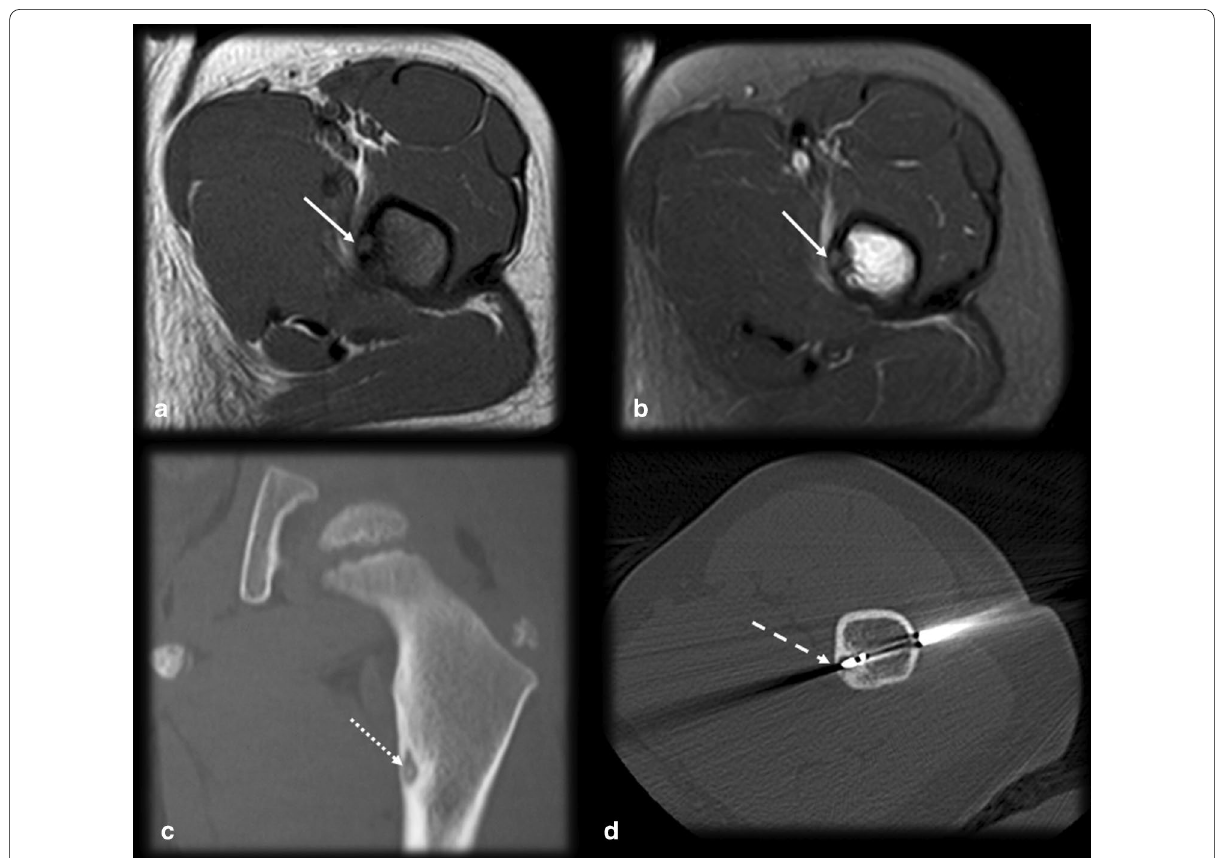
Fig. 1 Typical osteoid osteoma and percutaneous ablation. Male, 15 years old, presenting with medial hip pain for 2 months, which became worse at night. Axial T1 ( a ) and T2 FS ( b ) MR images showing a small cortical nidus (arrows) within the femur shaft with a target-like appearance, edema and sclerosis. CT ( c ) better detected the partially mineralized nidus (dotted arrow), cortical thickening and sclerosis than did MRI. CT percutaneous biopsy and radiofrequency ablation ( d ) were performed (dashed